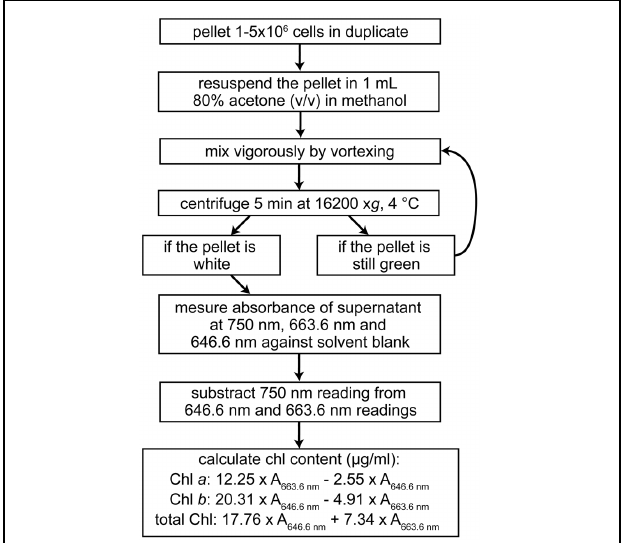
FIGURE 7 | Workflow for the spectrophotometric determination of the chlorophyll content of Chlamydomonas cells. Calculations are based on Porra et al.